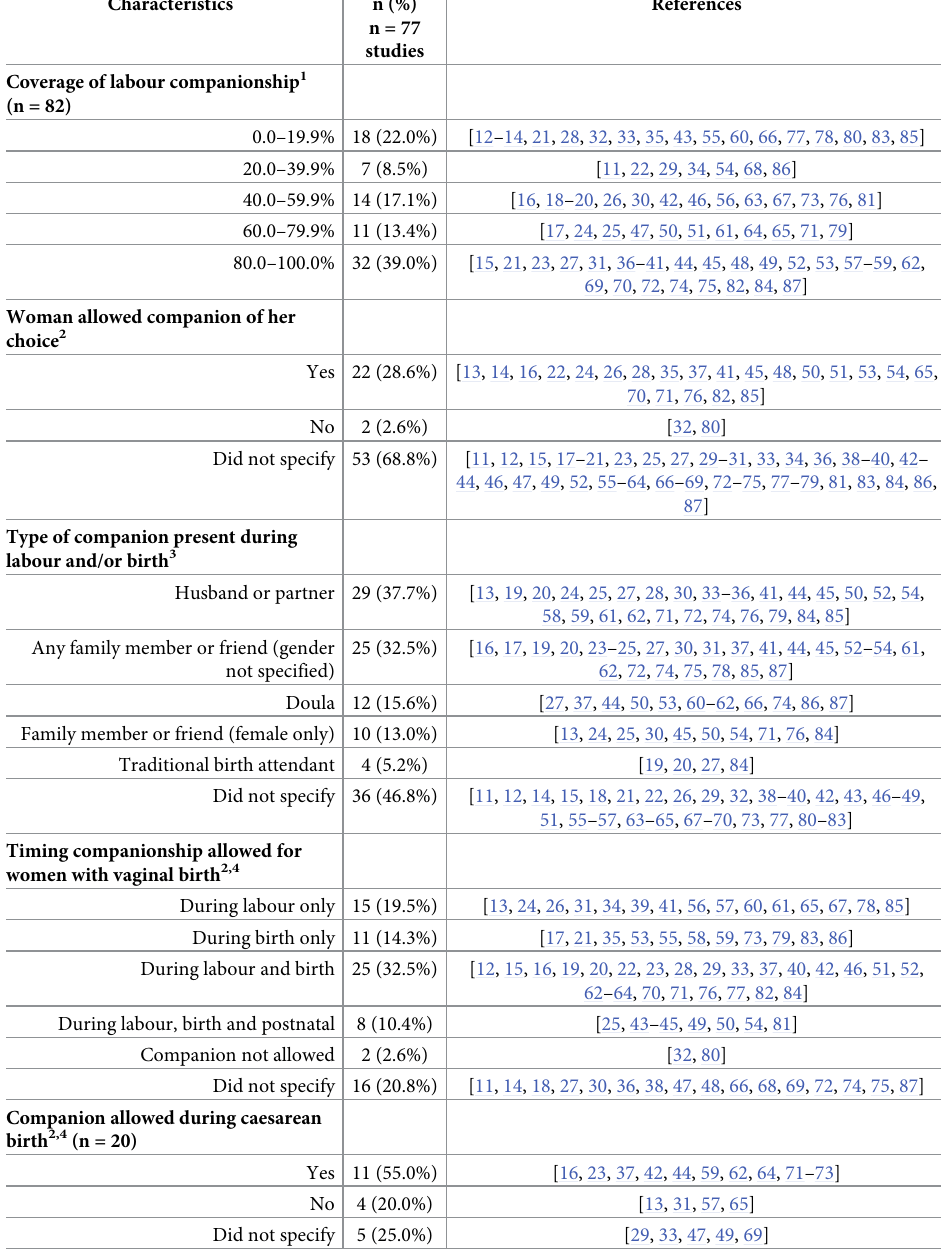
Table 2. Labour companionship coverage and